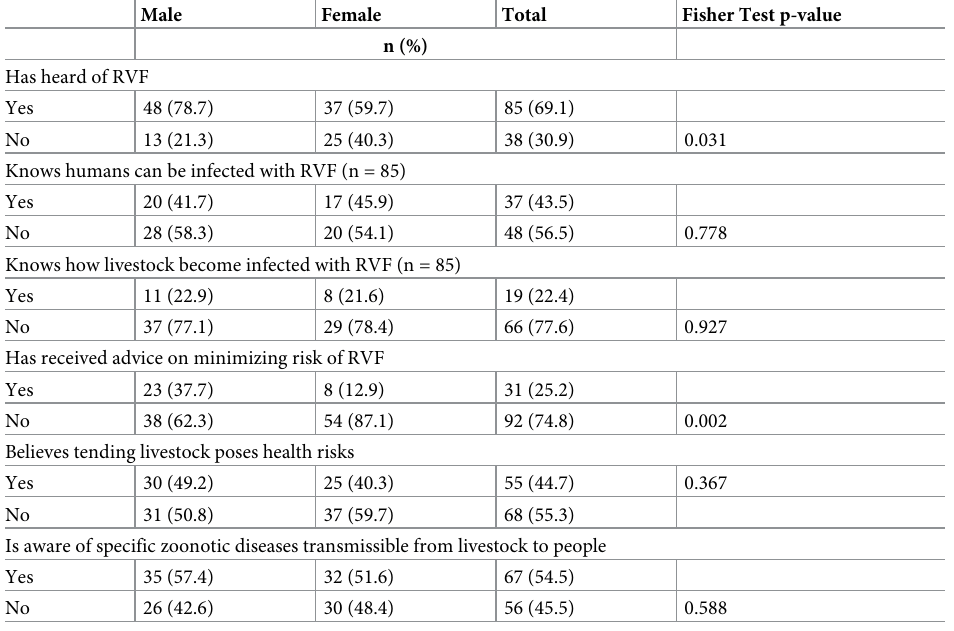
Table 3. Knowledge and risk perceptions of Rift Valley fever among participants from Nyagatare District, Rwanda (N = 123). Male Female Total Fisher Test p-value